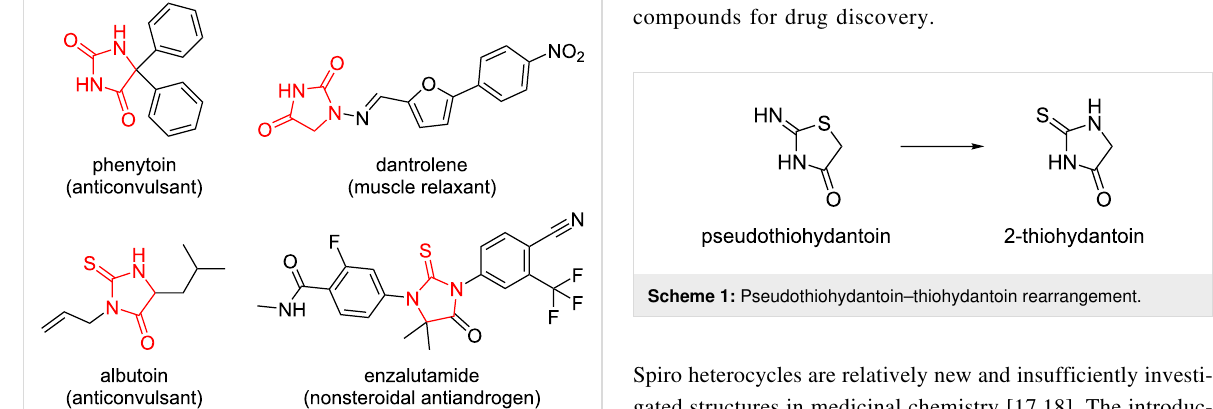
leged scaffolds or promiscuous binders, Mendgen and co-workers performed a systematic comparative study on rhodanines and related structures with respect to their medici- nal chemistry properties [7]. As a result, it was shown that such structures could be suitable scaffolds for medicinal chemistry under proper conditions of biological evaluation, while their medicinal chemistry properties dramatically depend on the structure of the five-membered heterocyclic moiety and substit- uents in the C-5 position